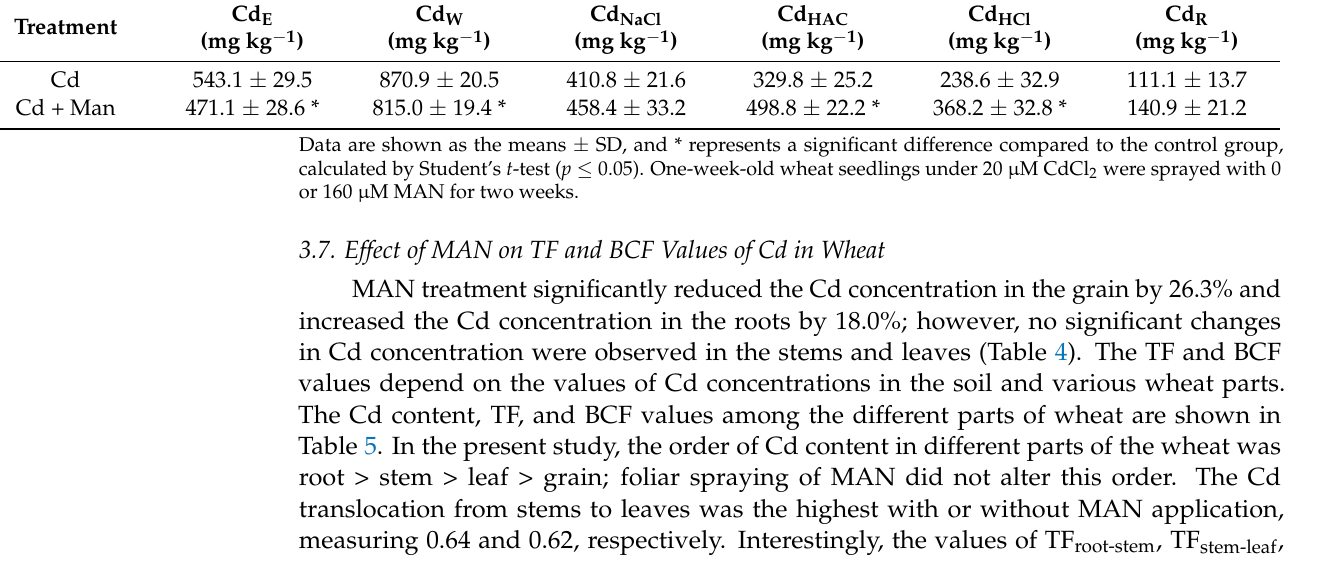
Table 3. Effect of MAN on the chemical forms of Cd in wheat roots under Cd stress.